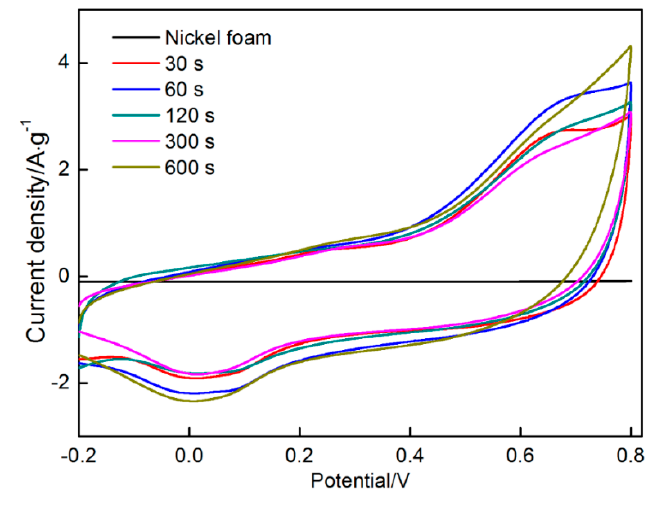
Figure 13. CV curves taken from nickel foam and MnO 2 deposits.